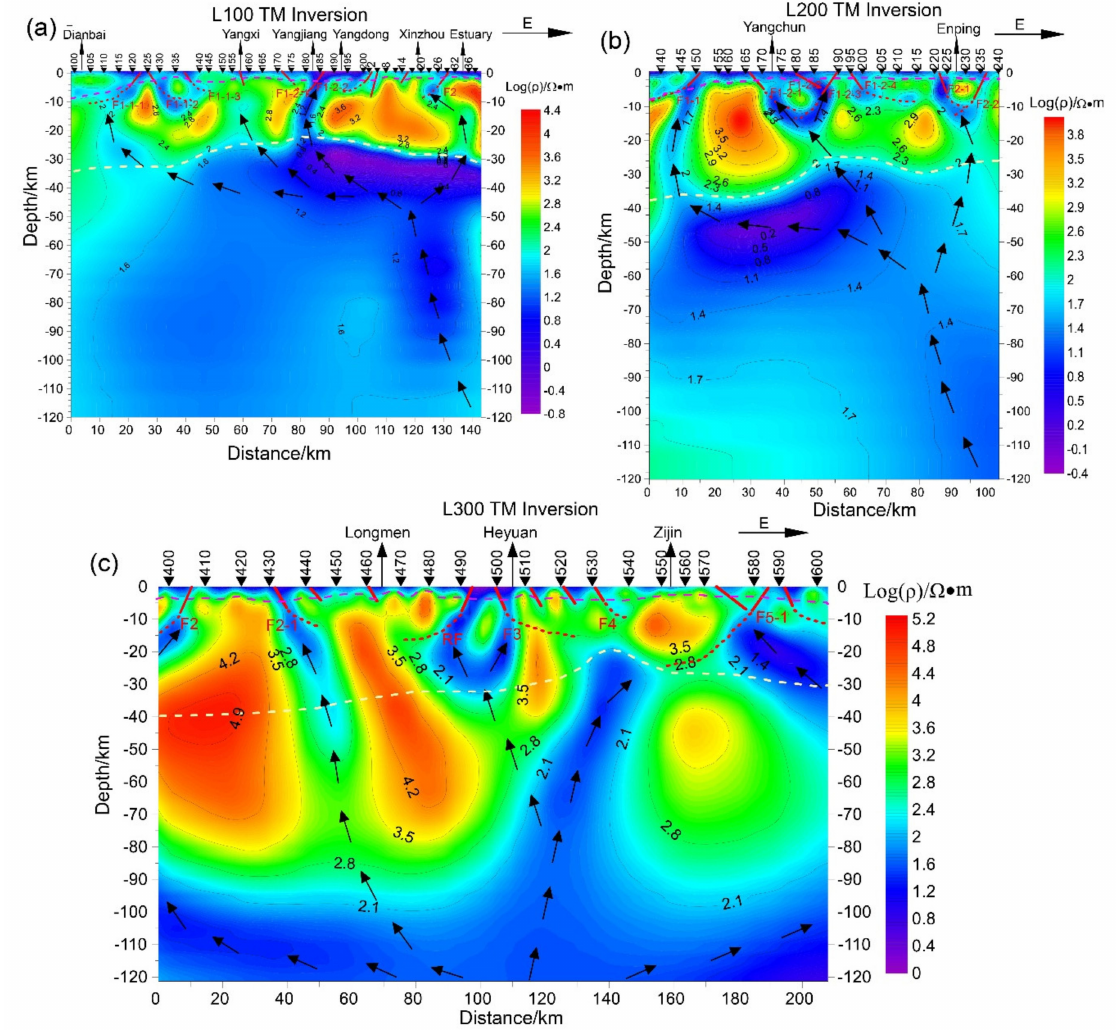
Figure 8. Preferred inversion model of electrical resistivity for the upper 120 km along the profiles with station locations and position of major tectonic features. F1-1, West part of F1; F1-2, East part of F1; F1, F2, F3, F4, and F5 are identical to that in Figure 2. The RF is the Renzishi Fault. The purple dotted line represents the inferred boundary between strata and Jurassic and Cretaceous granite; the yellow dotted line represents the inferred Moho boundary; the black arrow represents the upwelling direction of mantle